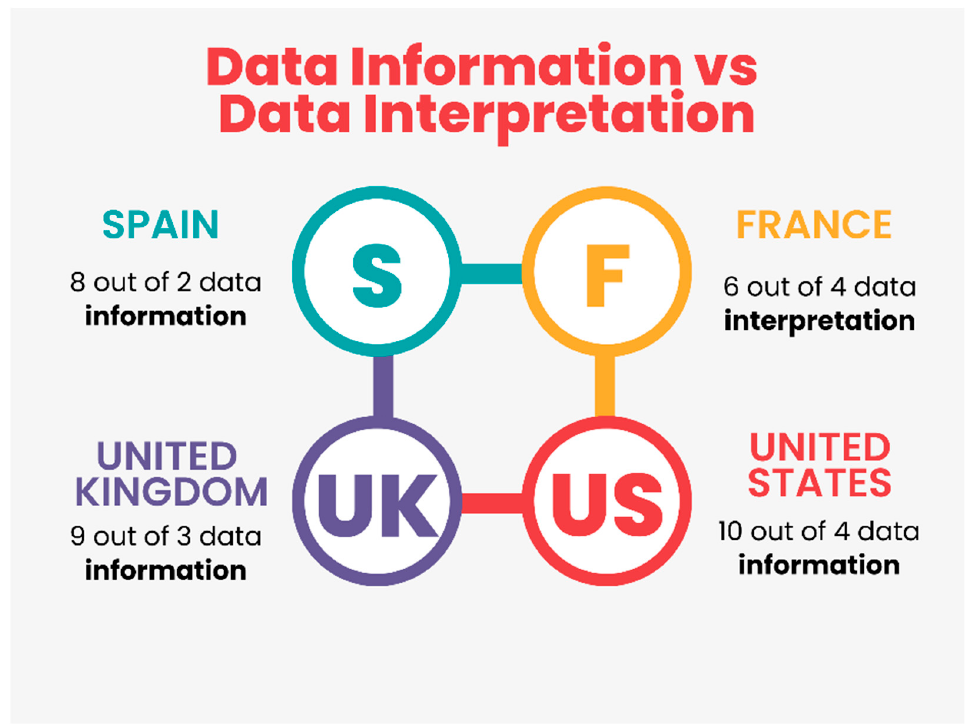
Figure 3. Data information vs. data interpretation.